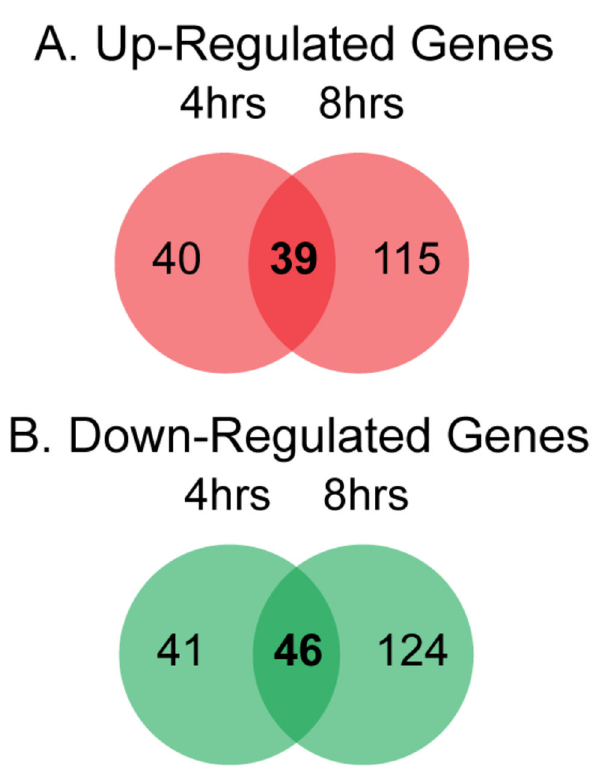
Figure 2. Comparison of the genes up- and down- regulated at each time point. The Venn diagrams depict the number of genes with significant changes in expression at both the 4 and 8-hour post-infection time points, with the number in the middle representing genes up- or down-regulated at